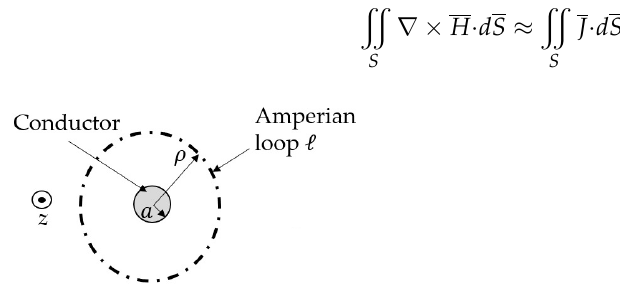
Figure 1. Cross-section of the conductor and the associated amperian loop.